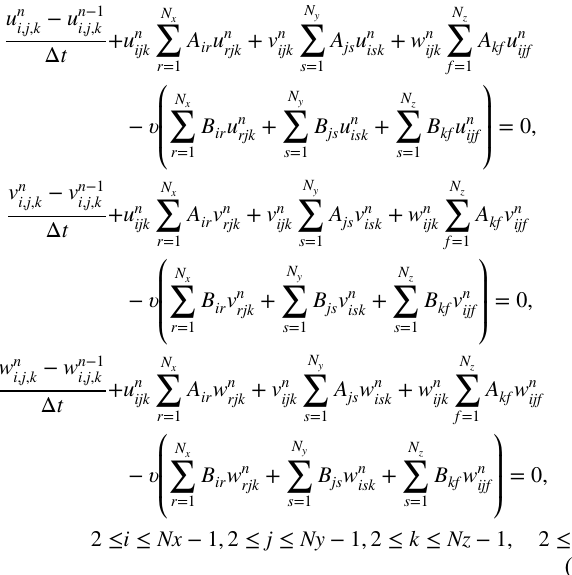
longitudinal velocities using the DQ-FD method in t = 0.01 and comparison with other numerical methods